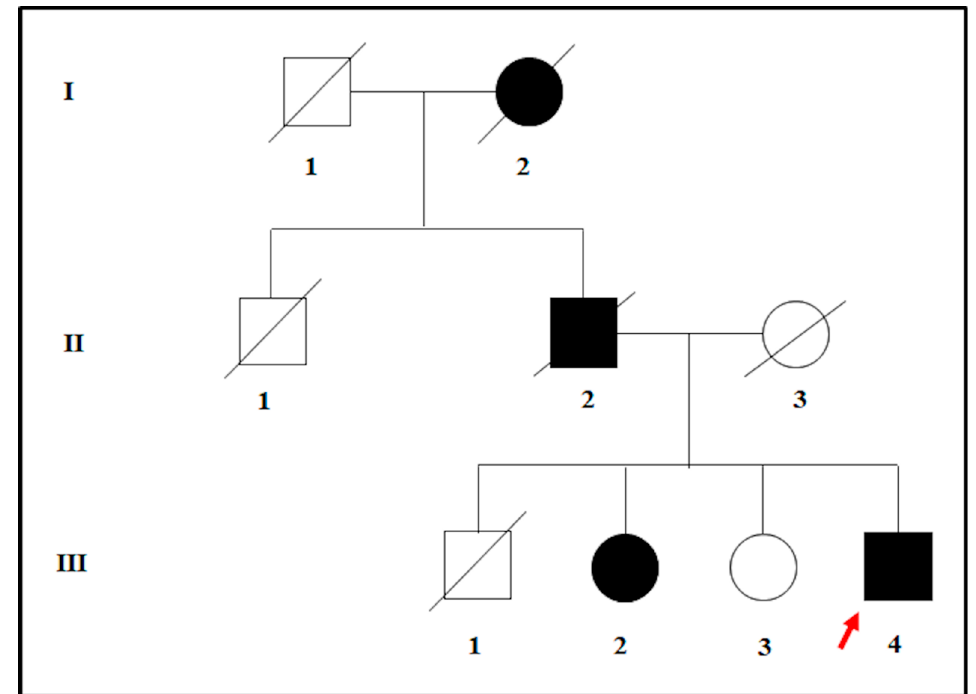
Figure 1. Pedigree tree illustrating the possible autosomal-dominant transmission of disease within the family of the proband. The red arrow indicates the proband.